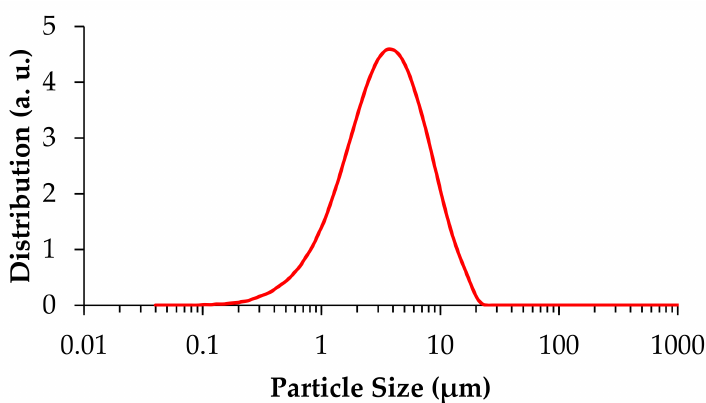
Figure 1. The particle size distribution of the milled